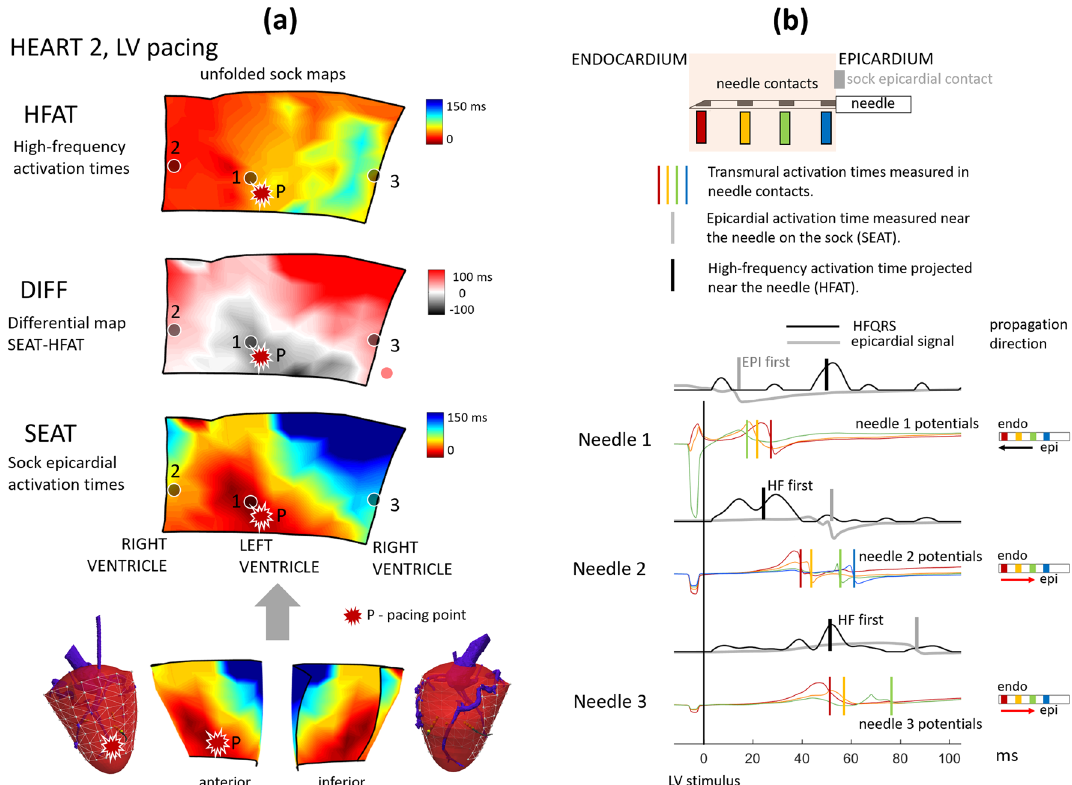
Figure 2. HFECGI theory validation using ex-vivo data. ( a ) Comparison of different activation maps on the sock—high-frequency activation times computed from torso records (HFAT), epicardial activation times computed from epicardial sock contacts (SEAT), and differential (DIFF) activation map computed as difference SEAT-HFAT. The red color in DIFF map means endo → epi direction, gray color means epi → endo direction (see Fig. 3). Marks 1,2,3 identify the position of needles. P marks identify the position of LV epicardial pacing. ( b ) Transmural depolarization wavefront propagation using signals from needle electrodes. Each needle electrode contained 4 contacts, marked by color (blue = close to epicardium; red = close to endocardium). The vertical color lines in the needles potentials indicate related activation time being the maximum negative derivative in each signal. If the blue contact is not shown, its position was outside the epicardial tissue. The gray signal represents epicardial potential measured on the sock contact in close proximity to the needle. The black signal represents high-frequency envelopes projected on epicardium to the needle position. The gray and black vertical marks define the epicardial activation time measured on the sock (SEAT) and the time calculated by the HFECGI method (HFAT), respectively. Complete results of two pig hearts with LV and RV pacing are shown in the Supplement, Figures